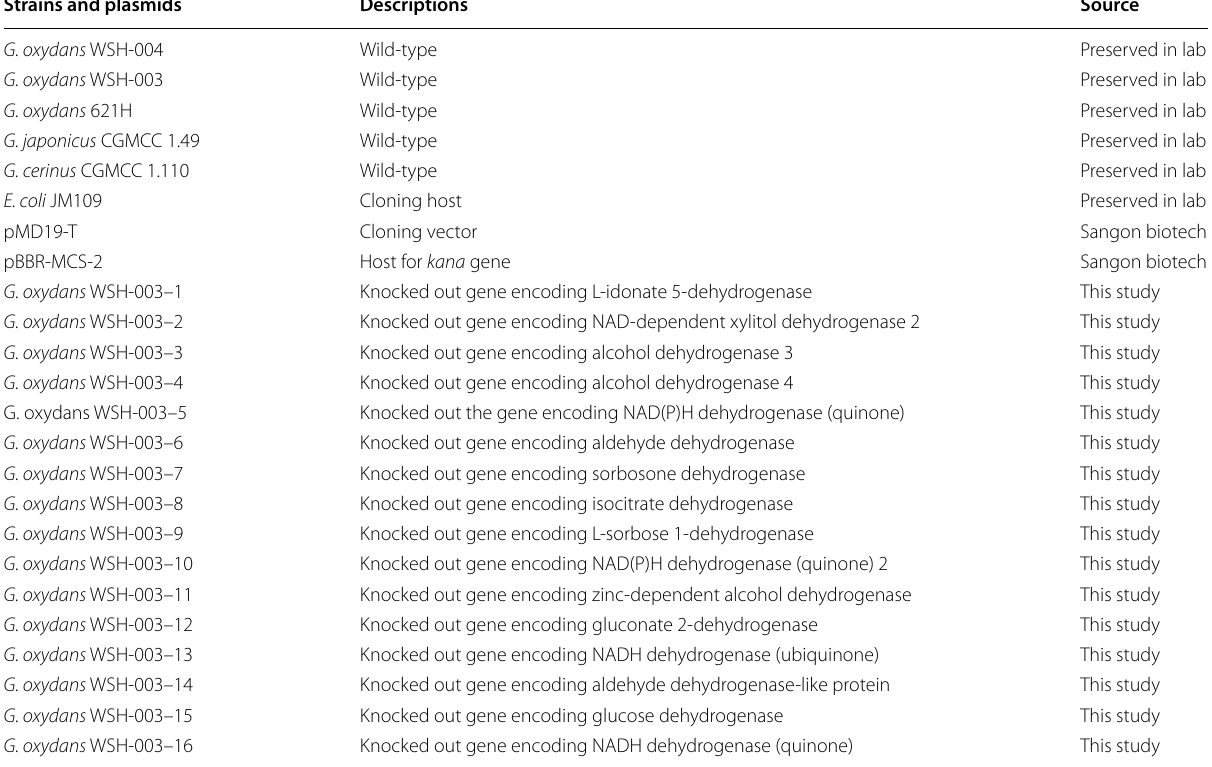
Table 1 Study strains and plasmids Strains and